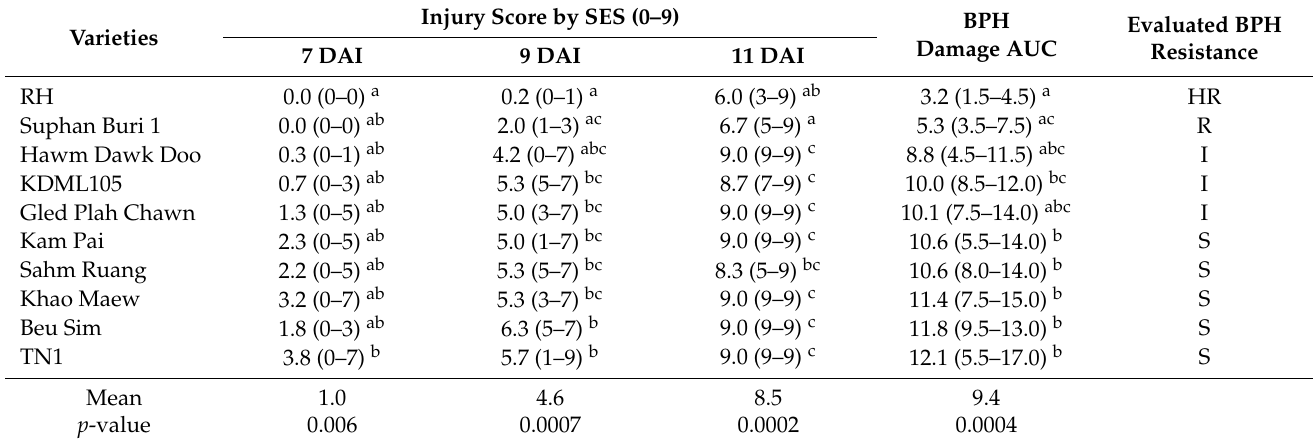
Table 2. Injury levels by BPH obtained by SSBS test and evaluated BPH resistance of 10 rice varieties. Injury Score by SES Varieties